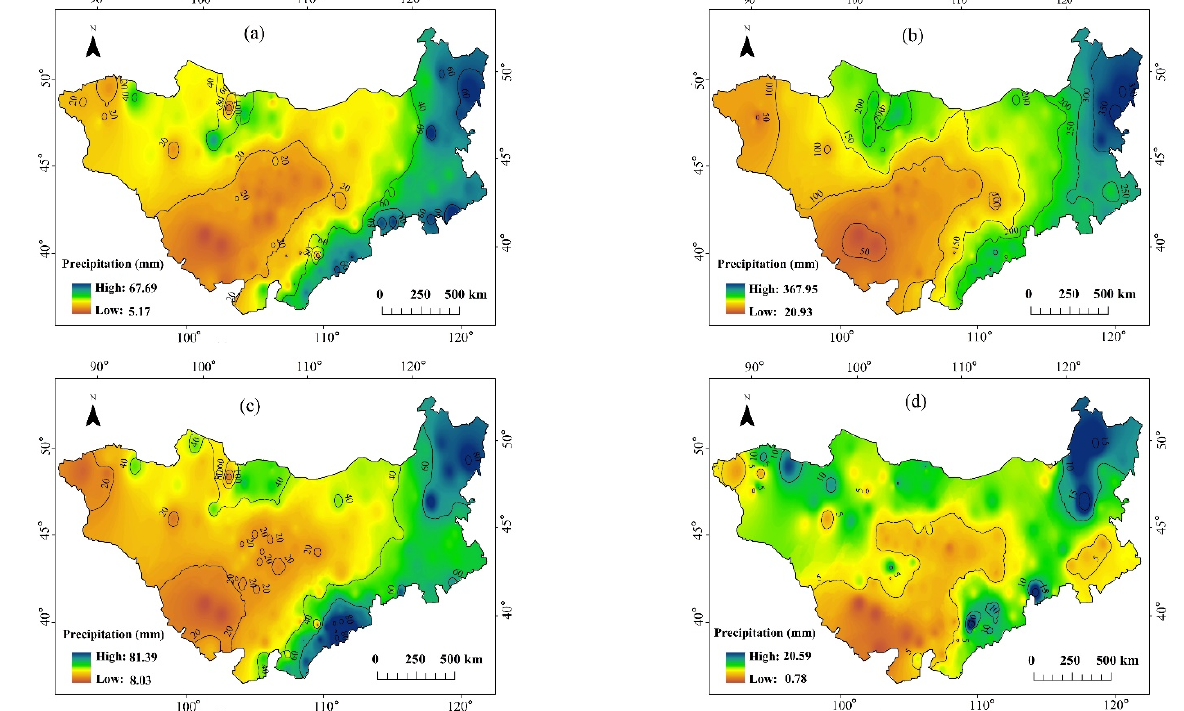
Figure 5. Spatial distribution of average precipitation of 135 stations during 1976–2017 in the Mongo-